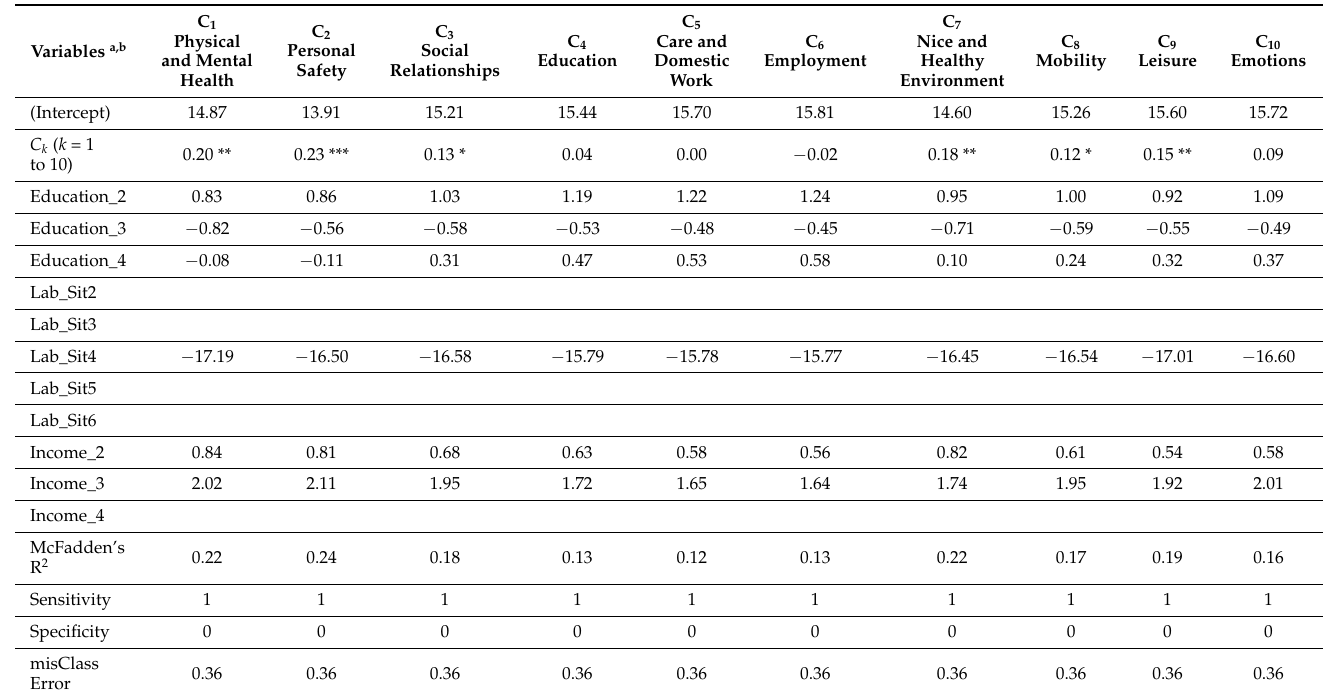
Table A8. Significance of coefficients of regressions with different capabilities. Men and age 65 and